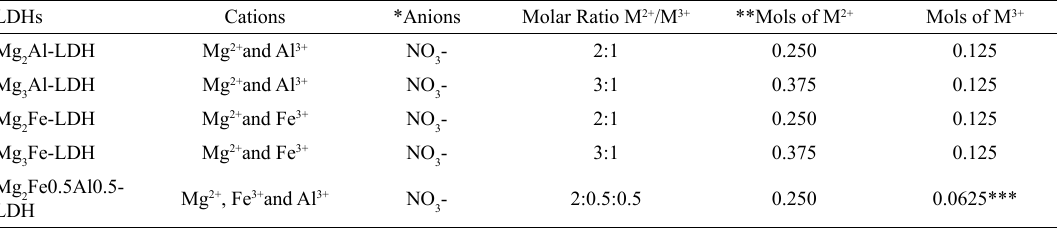
Table 1. List of cations, anions, molar ratio of cations and number of mols used for pristine LDHs